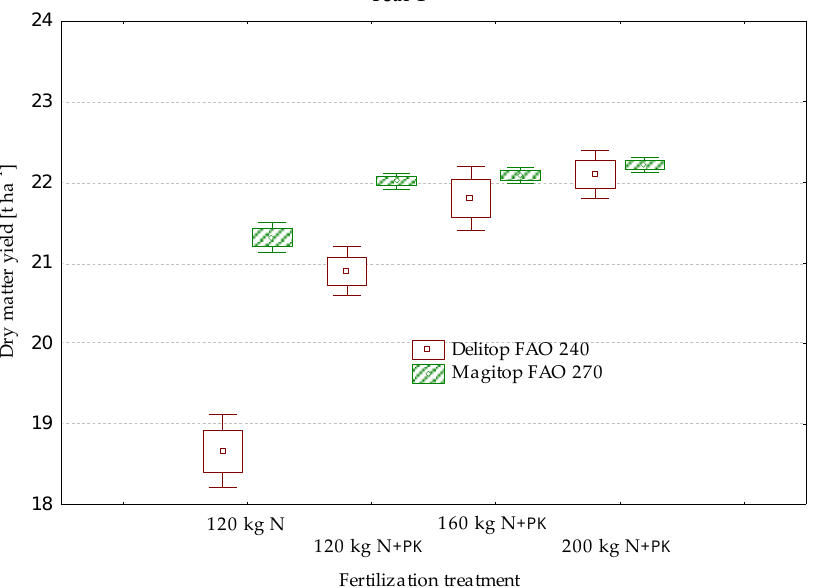
8 of 13 Figure 3. Boxplot of the SPAD index at successive measurement dates of in relation to maize variety. These results clearly indicate that nitrogen nutrition of these plants was significantly worse. This reaction may have been caused by the slower dynamics of this nutrient up-